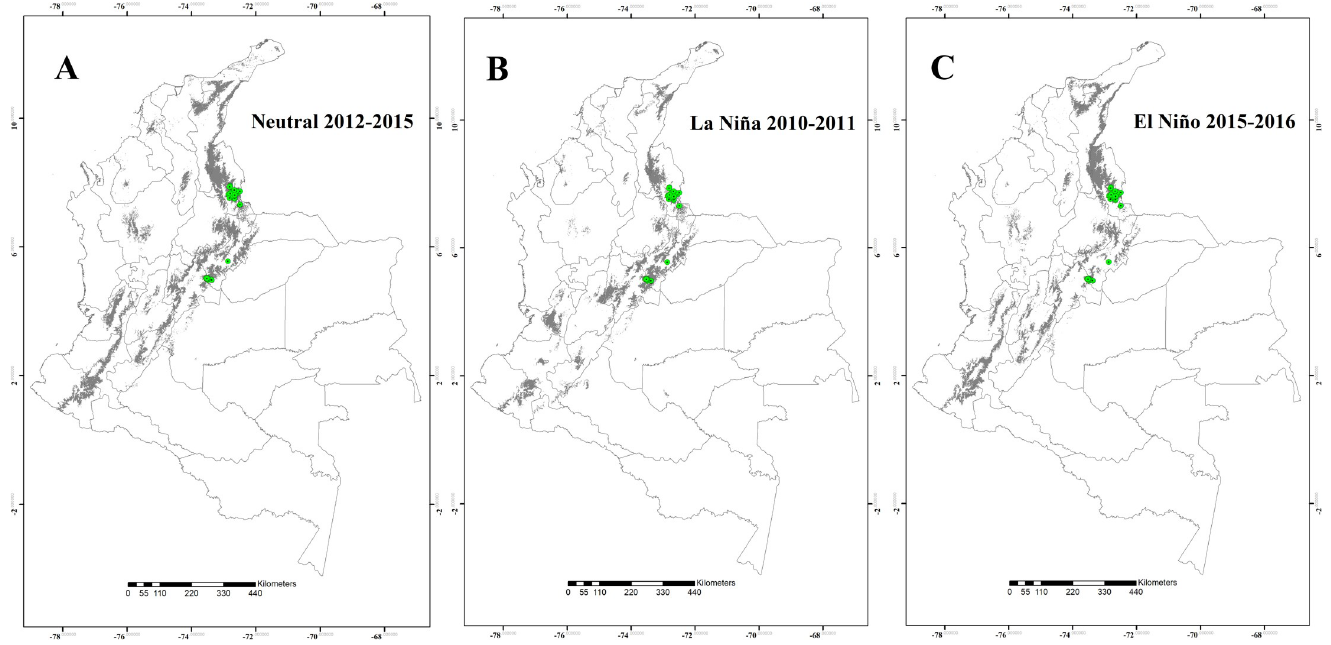
Fig 4. Potential distribution maps for Lutzomyia spinicrassa . (A) Neutral 2012–2015 episode. (B) La Ni ñ a 2010–2011 episode. (C) El Ni ñ o 2015–2016 episode. Models were calibrated across the hypothesized area of dispersion (M) and transferred across all Colombia. Green points are occurrences, gray areas are modeled suitable conditions, and white areas are unsuitable conditions. Points correspond to data in S1 Appendix, and maps were done using Maxent and ArcGIS software.